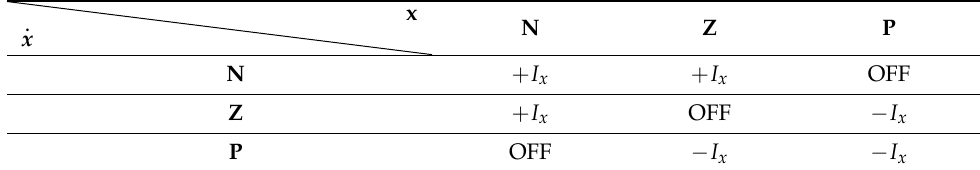
Table 2. Fuzzy rules used in FBBRC. I x = 0.5